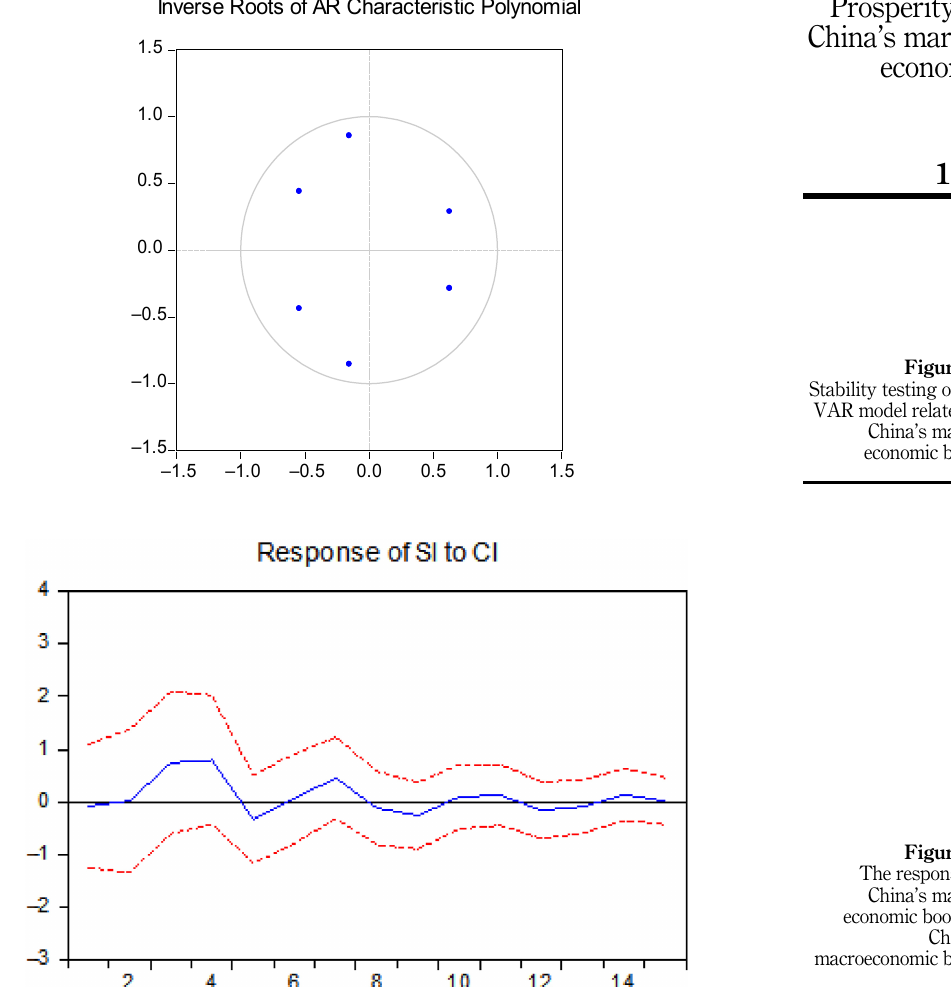
Figure 6. The response of